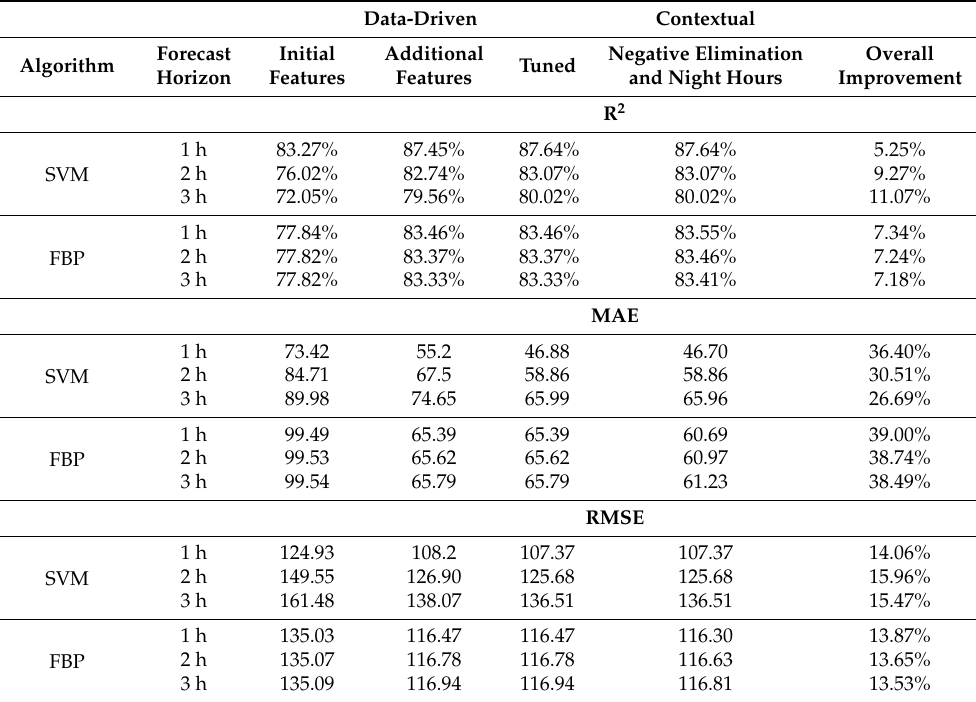
Table 4. Short-term results using data-driven and contextual